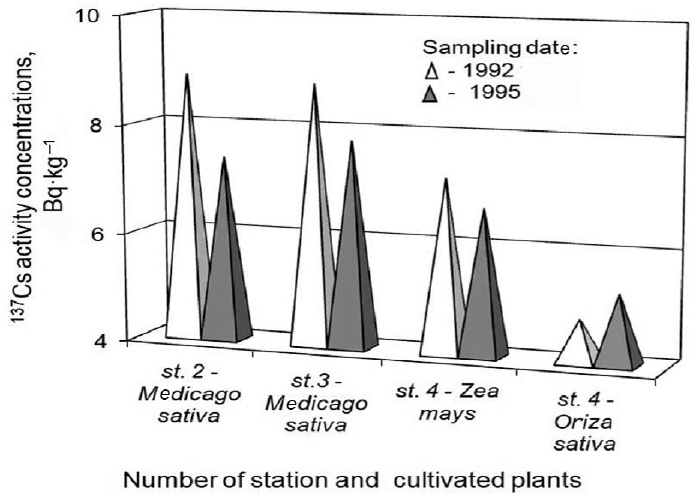
Figure 10. The 137 Cs activity concentration in irrigated soils (d.w.) under various crops. The determination of radionuclides in the green mass of cultivated plants showed that the accumulation levels of 239,240 Pu were low and varied from 65 to 77 mBq · kg − 1 (d.w.) in Medicago sativa , and from 0.2 to 2.5 mBq · kg − 1 (d.w.) in Oriza sativa